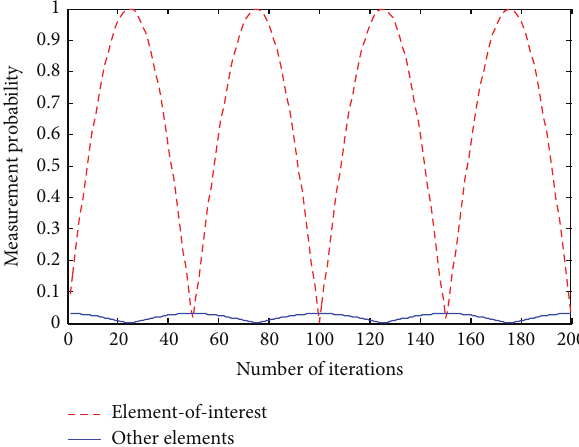
Figure3:Probabilityofsuccessbythenumberofamplitudeamplifi- cation iterations amongst 2 10 probabilities. For 10-qubit search, first highest probability of success happens at 25th iteration.